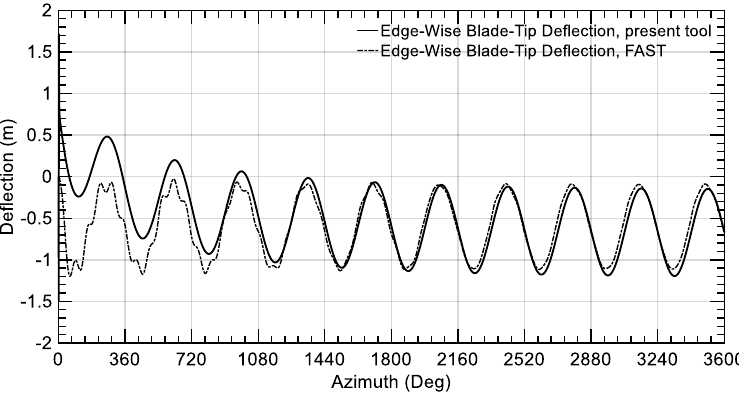
Figure 13. Blade-tip, edge-wise deflection.